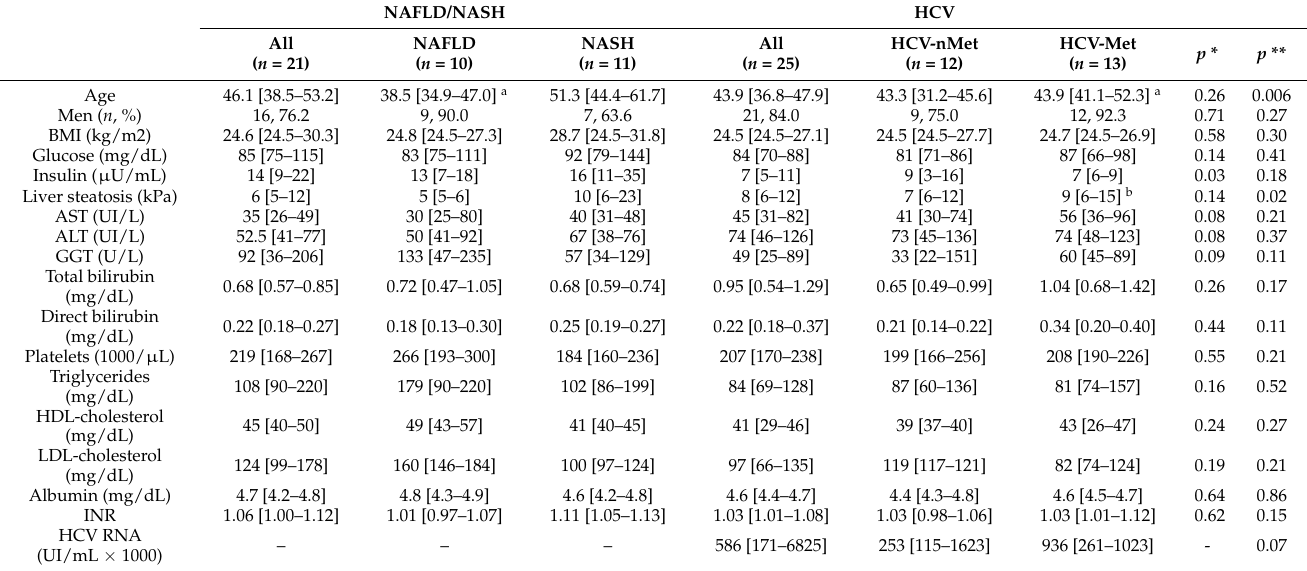
Table 1. Anthropometric and biochemical characteristics of study participants.